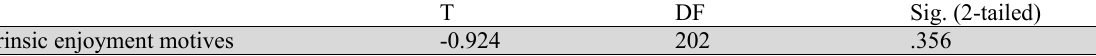
Independent sample test for challenge